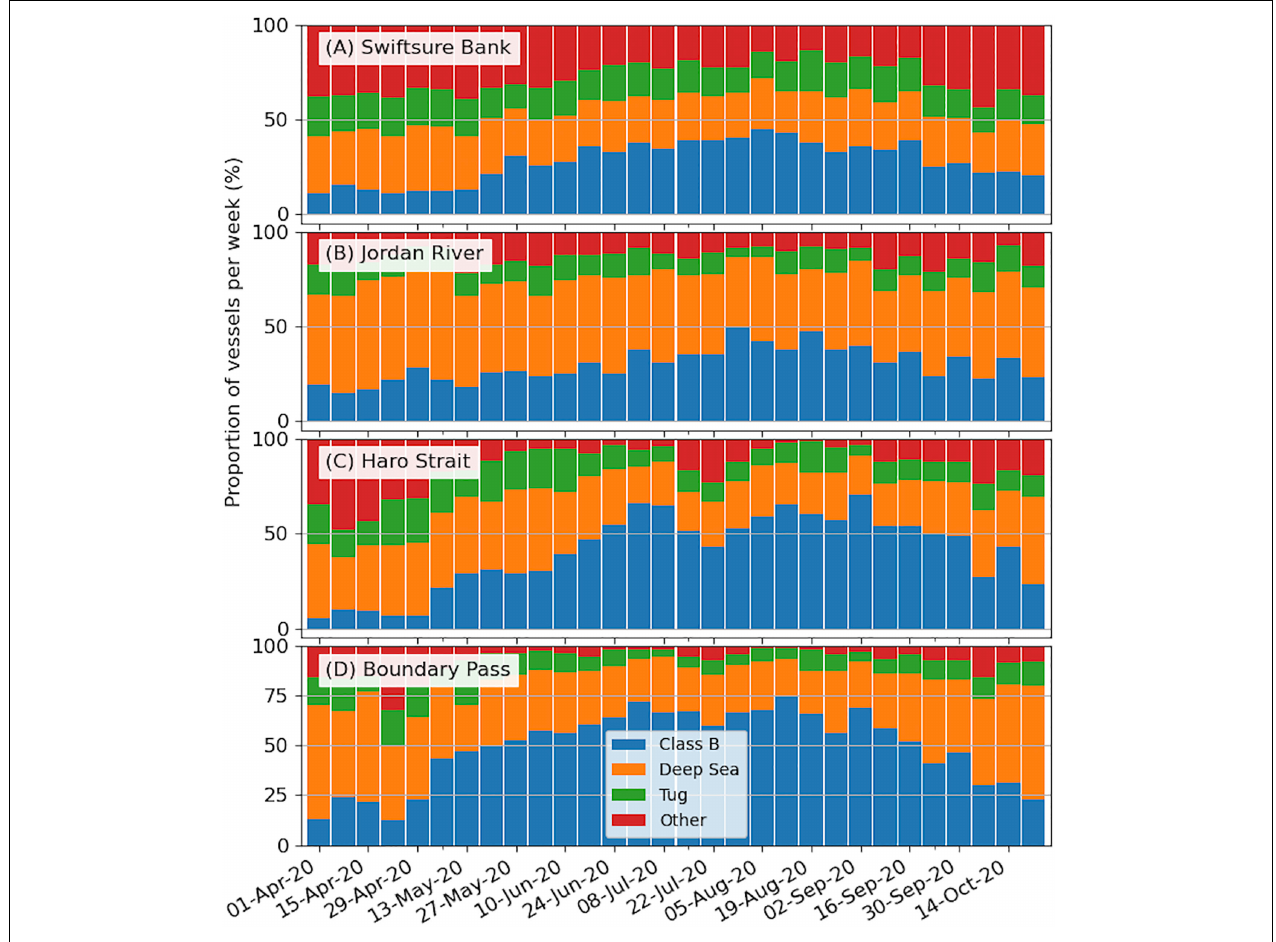
FIGURE 6 | Vessel passages by type within 8 km of the mooring expressed proportionally of weekly totals from AIS data for (A) Swiftsure Bank, (B) Jordan River, (C) Haro Strait, (D) Boundary Pass. The data were used to assess changes in the sound field based on vessel presence and participation. Trial for (A) Aug. 1-Oct. 31; (B) Jun. 1-Oct 31; (C) and (D) Jul. 1- Oct.